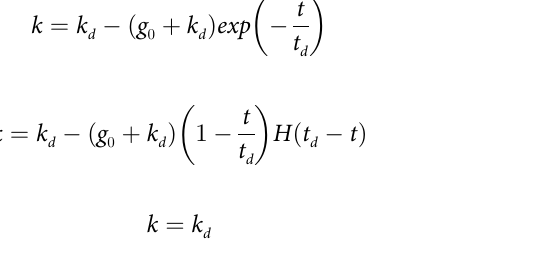
Table 1. Summary of model parameters. Parameters were either calibrated from growth data (see Methods - Model Calibration) or determined from longitudinal cell growth data (see Methods - Quantification of t